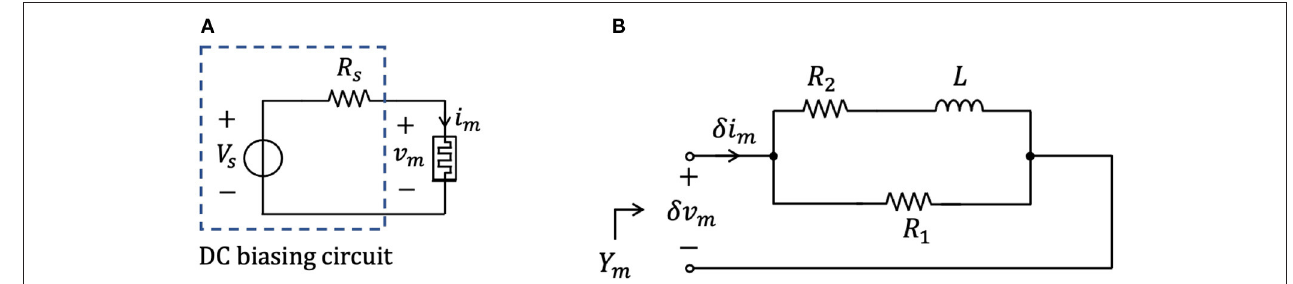
FIGURE 8 | (A) Biasing circuit for the stabilization of a given NDR operating point Q m introduction of a linear resistor of suitable resistance R s between the DC voltage source V s and the threshold switch is instrumental in stabilizing the NDR operating point. As will be clarified shortly, the condition for stabilizing Q m is R s > focus. (B) Small-signal equivalent circuit model of the voltage-controlled NbO memristor. The small-signal input admittance Y m ( s ) of the first-order memristive cell is computed from the port across the